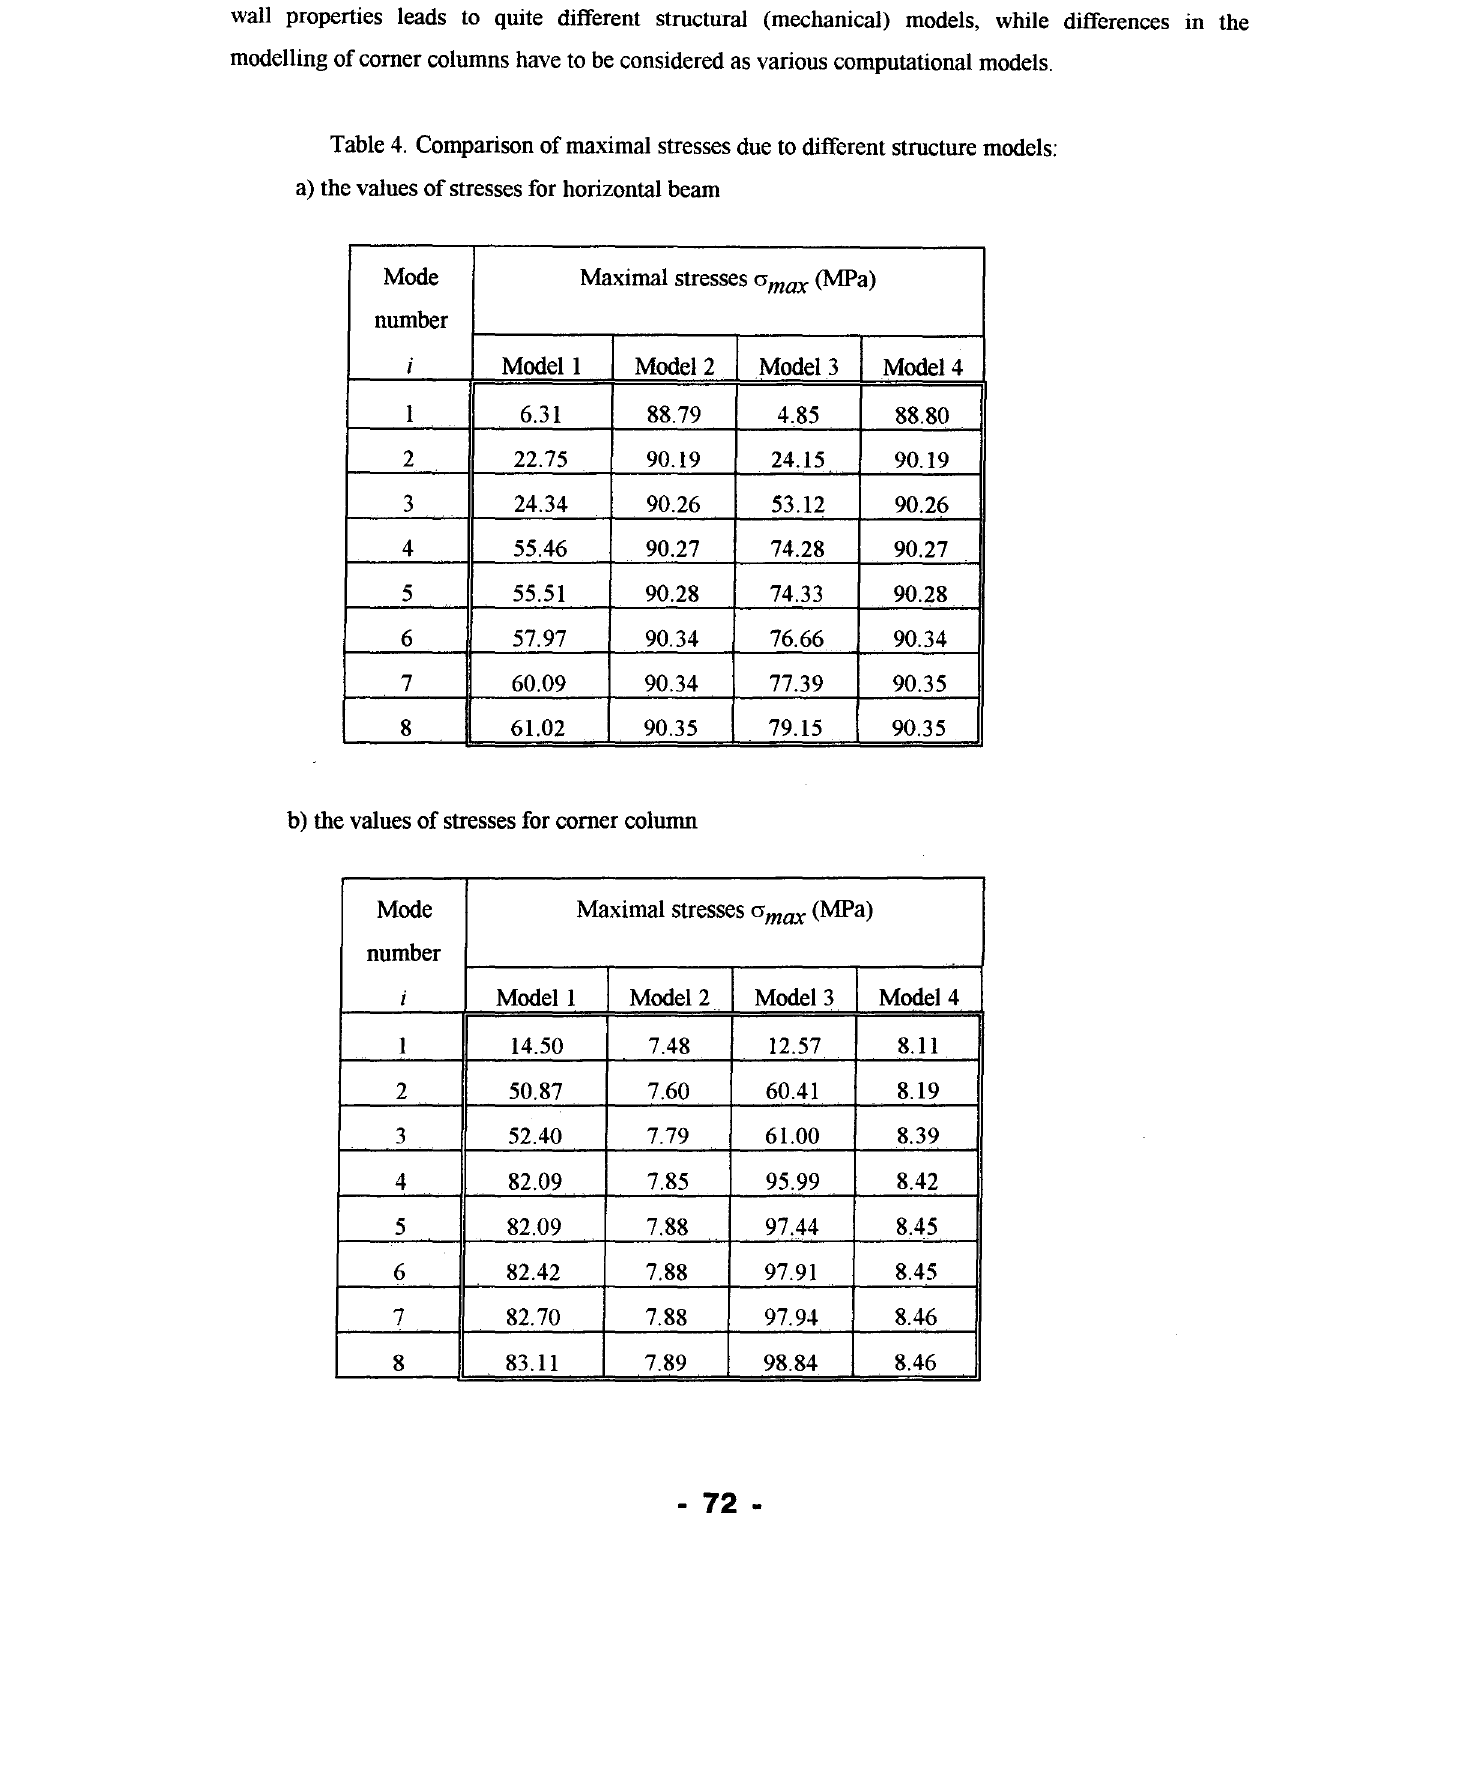
Table 4. Comparison of maximal stresses due to different structure